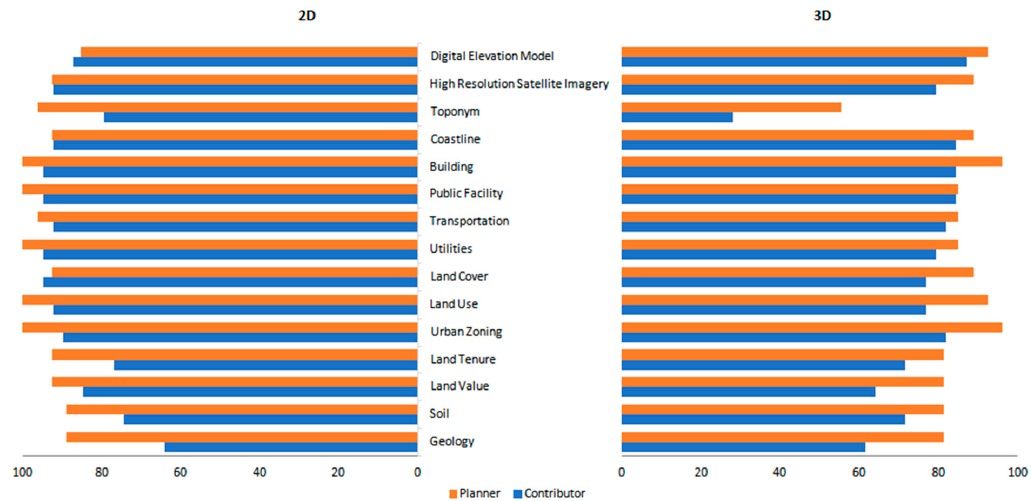
Figure 11. Preferences of spatial information to be used in participatory urban planning monitoring from the potential contributor ( red ) and urban planners ( blue ) (in percentages). from the potential contributor ( red ) and urban planners ( blue ) (in